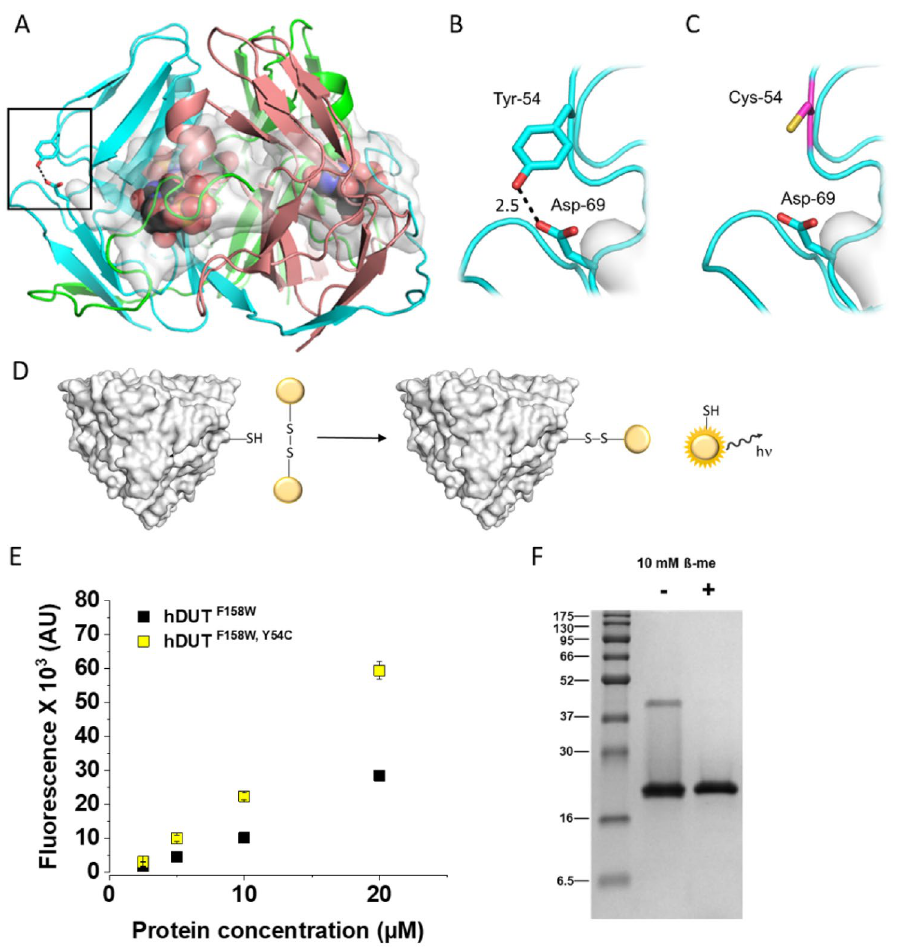
Figure 3. ( A ) Crystal structure of the human dUTPase (PDB ID: 2HQU). Protein is shown as cartoon, chains are coloured cyan, salmon and green. Substrate analogue dUPNPP is shown as spheres with atomic coloring (carbon: black, oxygen: red, nitrogen: blue, phosphorus: orange). Residues within 5 Å distance from the substrate analogue are shown as white partially transparent surface. In case of one of the dUTPase protomers side chains of Tyr-54 and its interaction partner Asp-69 are shown as sticks with atomic coloring (carbon: cyan, oxygen: red). Tyr-54 and Asp-69 residues are more than 5 Å distance from the active site of the protein. Black frame shows the position of close-ups on Panels B and C. ( B ) Close up of Tyr-54 in one of the dUTPase protomers. Coloring and representation is as on Panel A. Dashed black lines illustrate the hydrogen bond formed between Tyr-54 and Asp-69 (distance of the two residues in Å is indicated on the figure). ( C ) Close up of the introduced Cys-54 mutation to the protein with PyMOL in most abundant conformation (> 80%) of the residue (cysteine side chain is shown as sticks with atomic coloring: carbon: magenta, sulfur: yellow). Cys-54 and Asp-69 can not form a hydrogen bond as the distance of the sulfur from the oxygen atoms is 5.2 Å and 5.9 Å. ( D ) Scheme of the thiol quantitation assay. Solvent accessible, free cysteines react with the thiol assay reagent and a fluorophore is formed. The observed fluorescent signal is proportional to the amount of free cysteines in the sample. ( E ) Results of thiol quantitation assay of hDUT F158W and the hDUT F158W,Y54C . ( F ) SDS- PAGE gel of the hDUT F158W,Y54C protein in the absence and presence of 10 mM β-ME. (Full-length gel image is included in a Supplementary